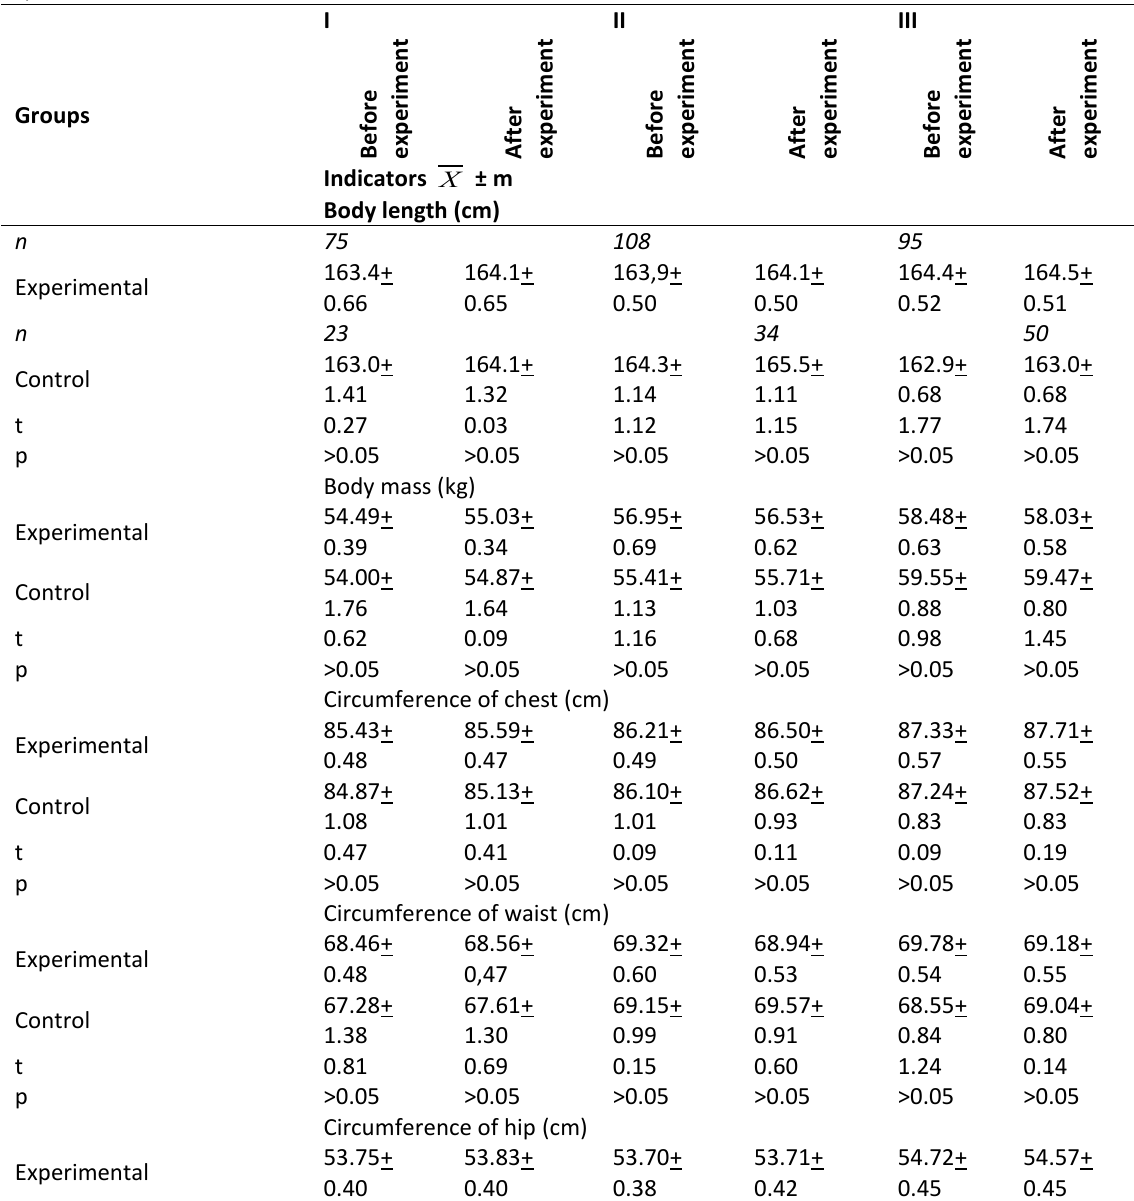
Table 1. Anthropometrical indicators of experimental and control groups’ girl students before and after